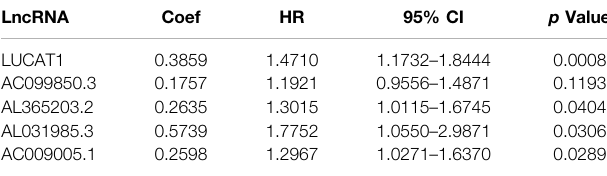
TABLE 1 | Multivariate COX regression analysis of ferroptosis-related lncRNA.